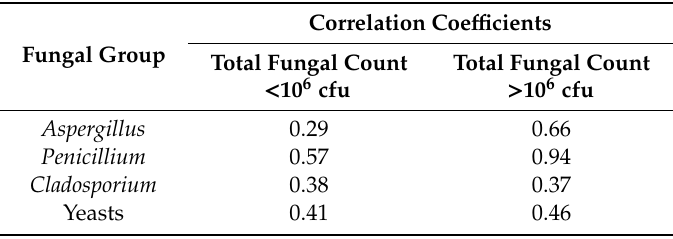
Table 2. Spearman’s rank correlation coefficient between the NGS and culture methods and a comparison of the two groups of house dust samples as divided by whether the total fungal counts/1 g house dust were above or below 10 6 colony-forming units (cfu).